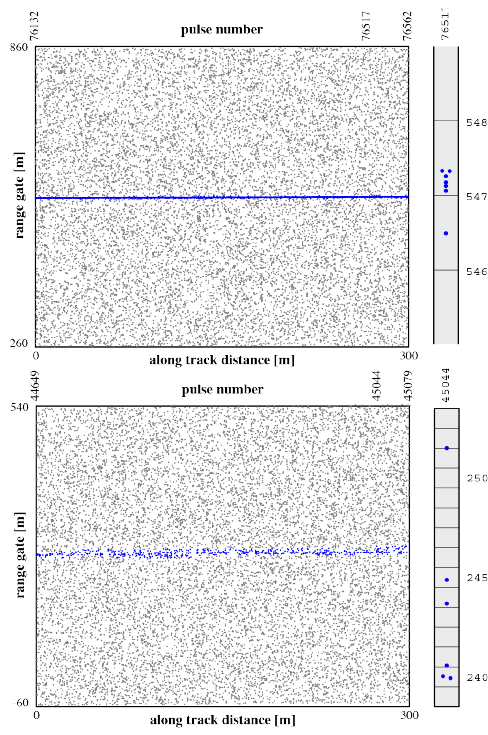
Figure 2: Shows 300 m long segments of two photon clouds. The gray dots are photon events and the blue dots represent signal